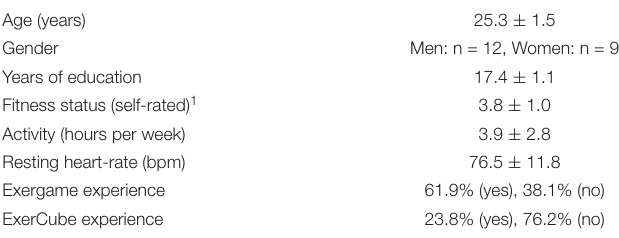
TABLE 1 | Baseline